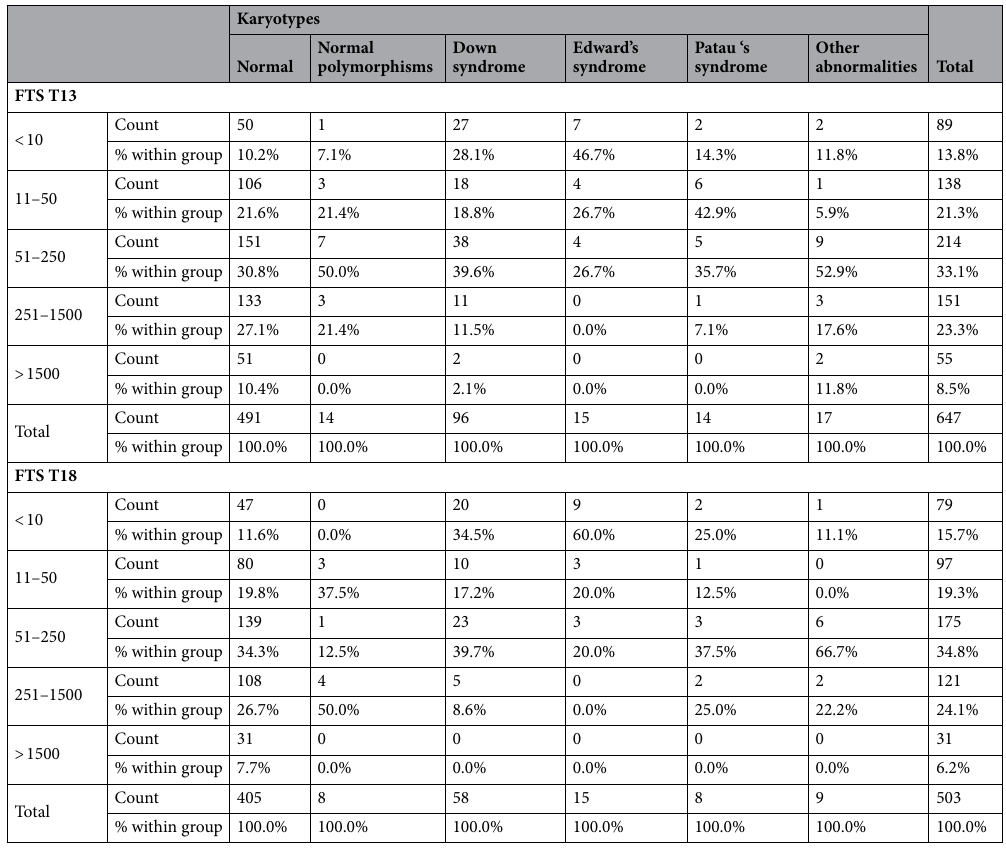
Table 11. Distribution of chromosomal abnormalities within different groups based on the risk calculated in first trimester screening (FTS) for Edward and Patau